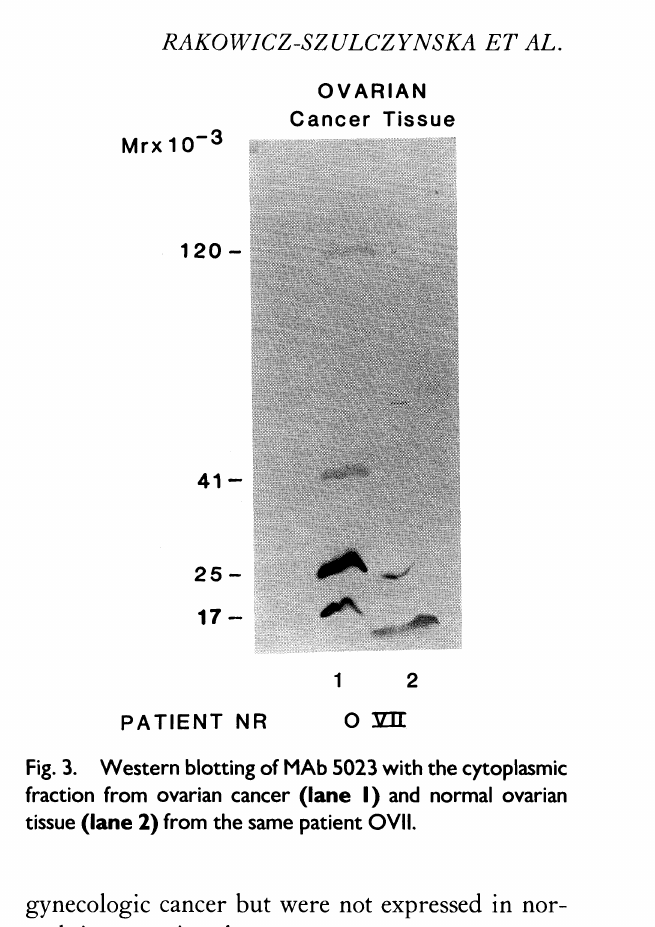
Fig. 3. Western blotting of MAb 5023 with the cytoplasmic fraction from ovarian cancer (lane I) and normal ovarian tissue (lane 2) from the same patient